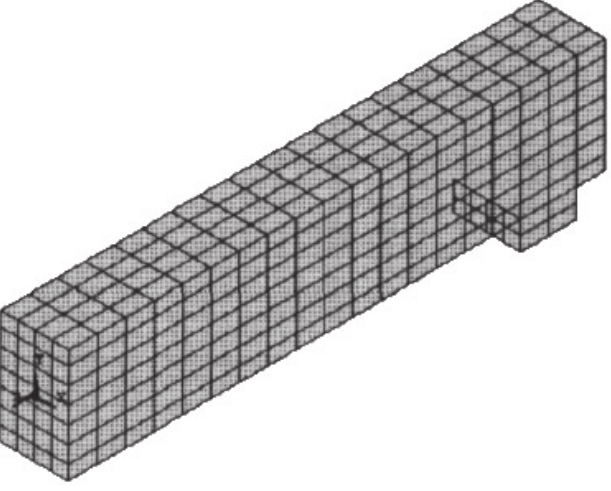
Figure 5: Grid generation of concrete